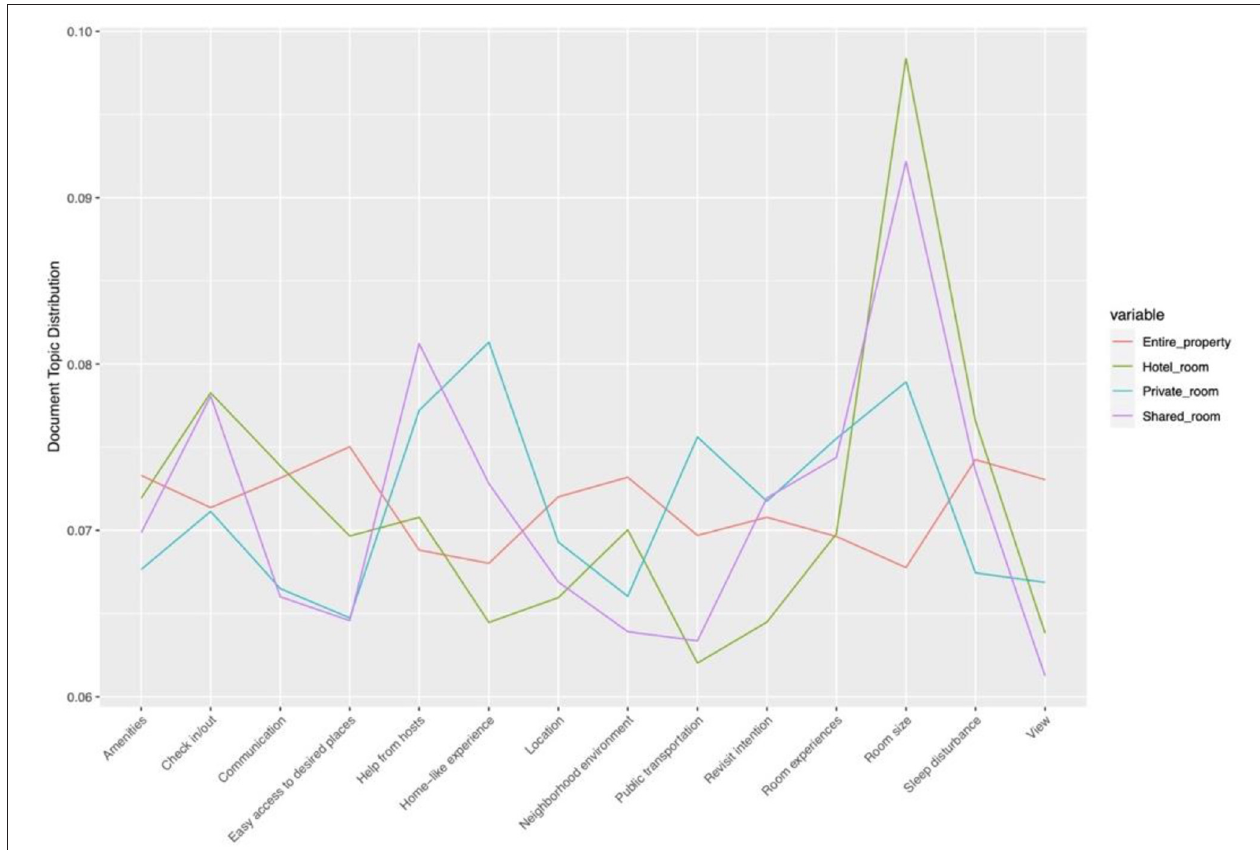
FIGURE 7 | Topic distributions in different Airbnb properties (positive reviews). Source: created by the authors.